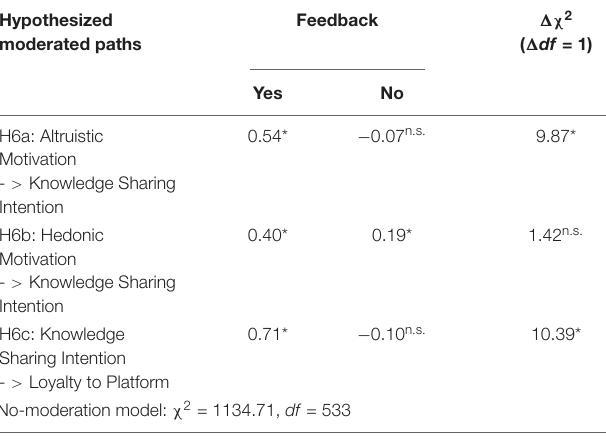
TABLE 3 | Results of multigroup